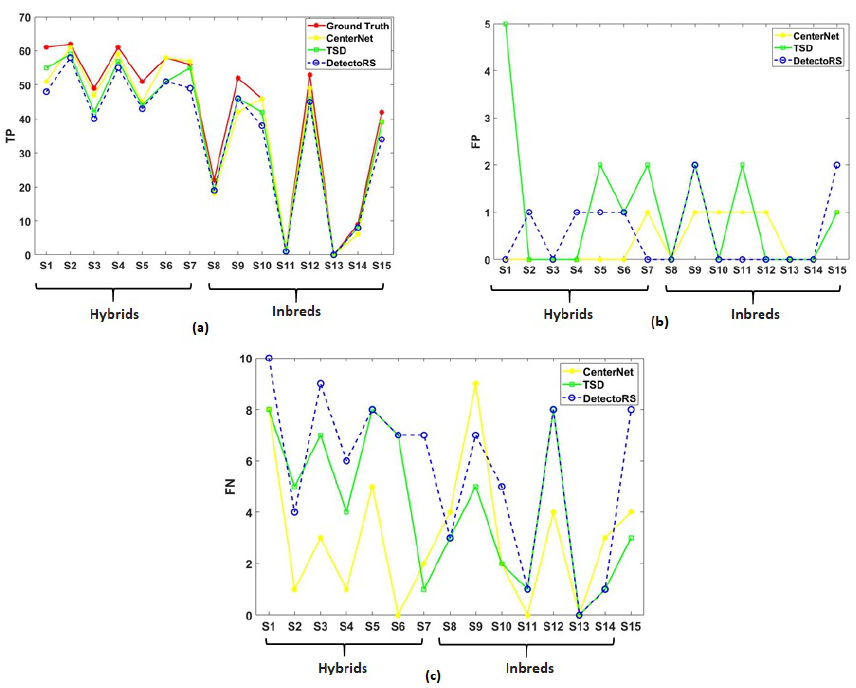
Figure 18. Results of Test (Ng: Red, CenterNet: Yellow, TSD: Green, DetecoRS: Blue). ( a ) TP. ( b ) FP. ( c ) FN.